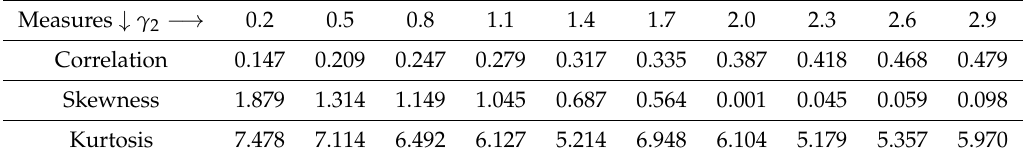
γ 2 Measures ↓ −→ Table 1. The correlation, skewness and kurtosis measures of the Burr X-exponential (BBXEx) (1.5,0.6, γ 2 ,1.5)